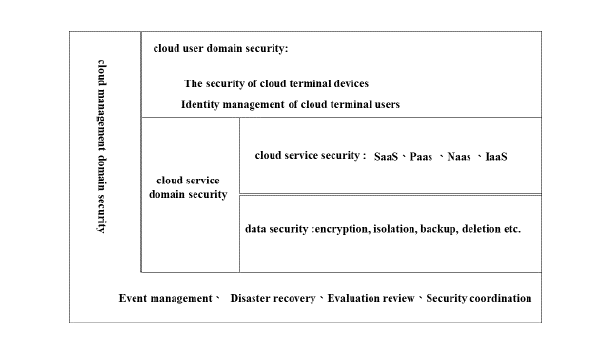
Fig. 1. Cloud Security Architecture